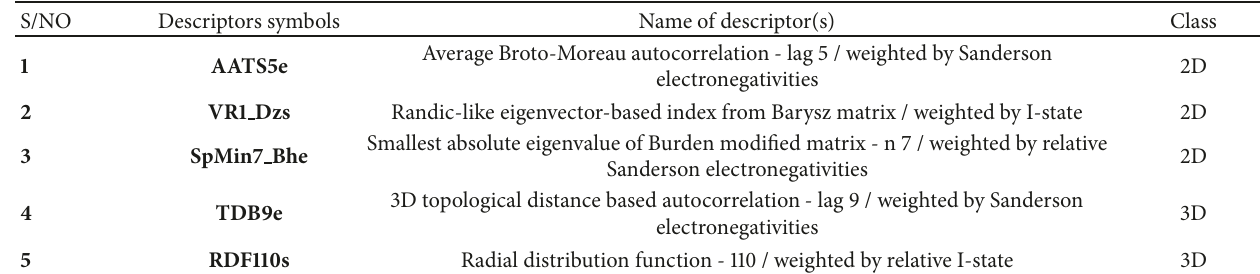
Table 3: List of some descriptors used in the QSAR optimization